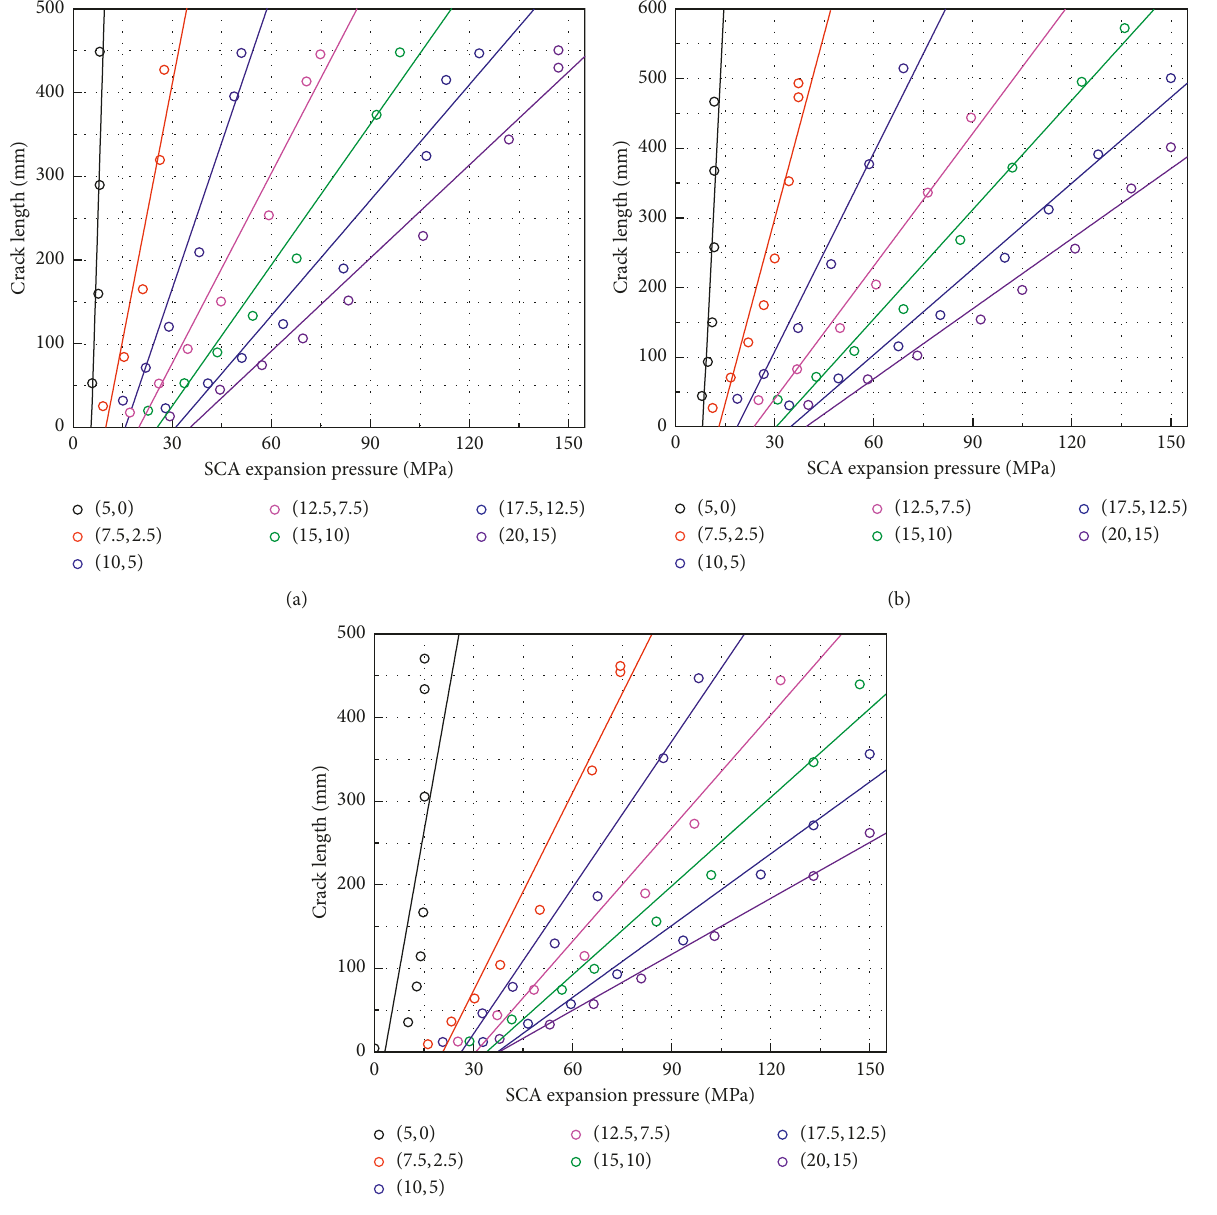
Figure 17: Variations of the crack length versus SCA expansion pressure under different stress and notch direction conditions. (a) θ θ 45 ° ; (c) θ 90 ° (cid:31) (cid:31)